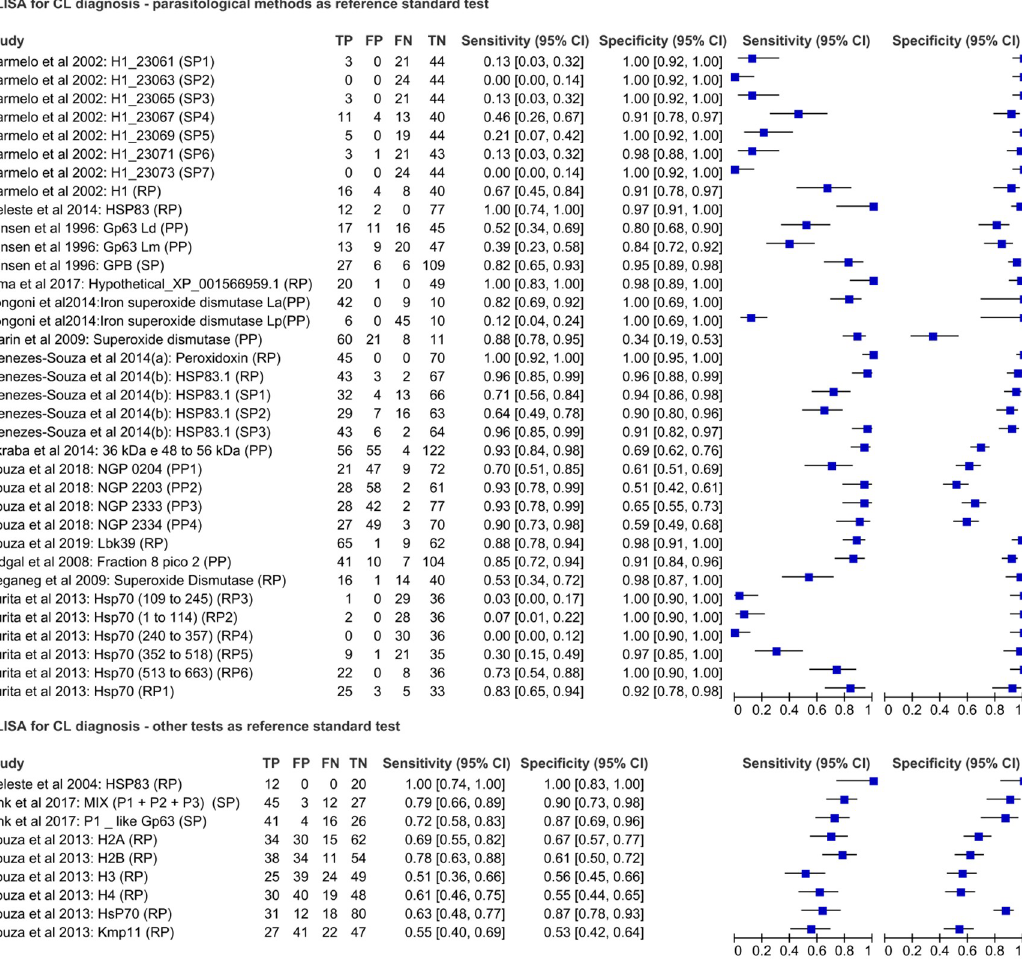
Fig 3. Forest plot representing sensitivity and specificity indices of ELISA using different antigenic targets for CL-diagnosis.